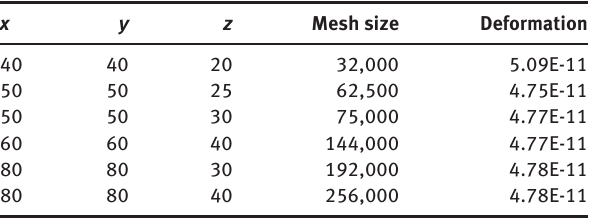
Table 3: Comparison of different combinations for mesh independ- ence check.